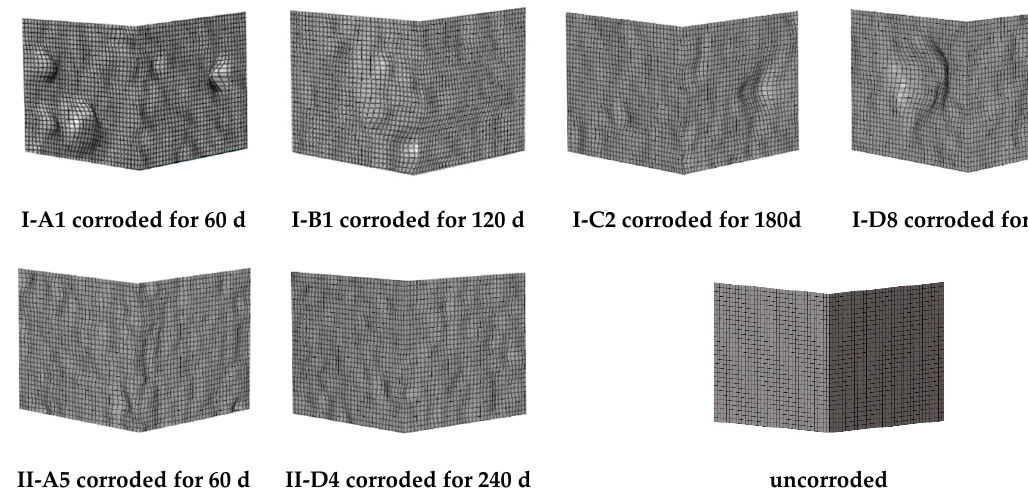
Figure 10. Simulated corners of the steel bridge pier showing damage due to different corrosion times. To promote a ULCF fracture in the numerical simulation, the loading path and axial compression ratio were the same as that described in Section 3.1 (see Figure 7). The loading pattern is shown in Figure 11.